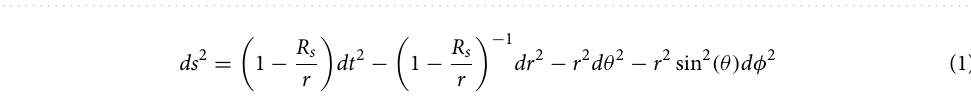
Figure 1. Simulated rays of light satisfying Eq. (3) with δ 0 < 0 (left) and δ 0 > 0 (right) with coloring indicating magnitude of δ 0 . The black hole is shaded in grey with the last photon orbit indicated with a dotted grey line. Each successive light-trajectory plotted is a factor of 2 closer to the photon capture radius with the resulting deflection angle increasing just below 40 ◦ . Thus, the logarithmic scaling towards the photon capture radius maps to a linear evolution in φ